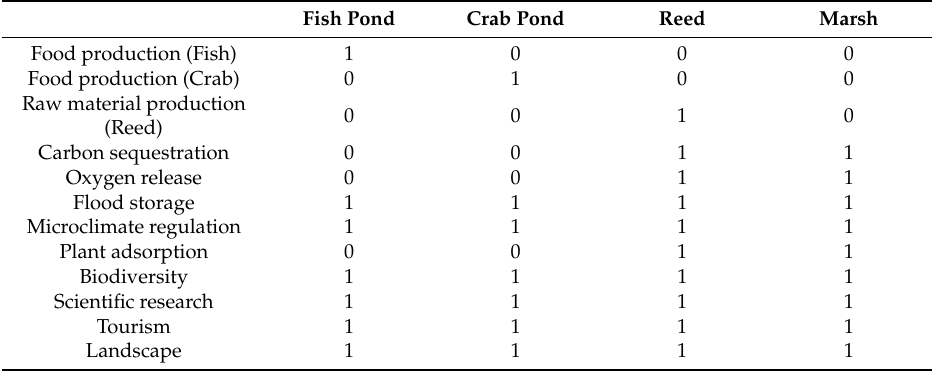
Table 4. Types of ecological services corresponding to different ecological functions in nature reserves.